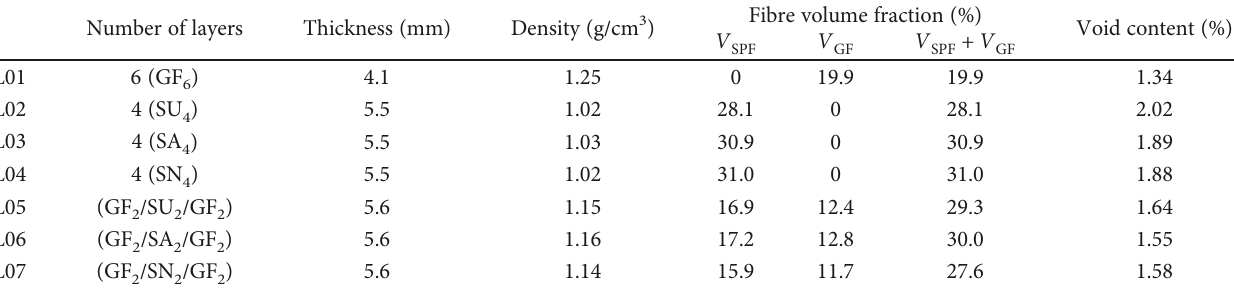
Table 2: Density and volumetric compositions of fi bre and void of the composites. Number of